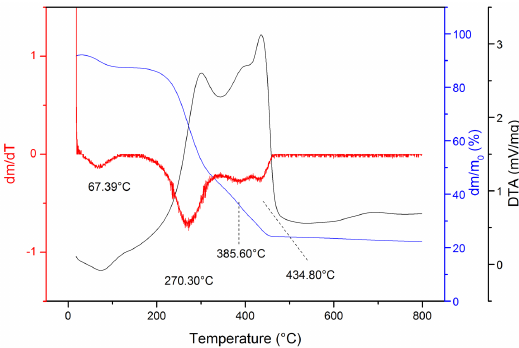
Figure 6. TG/DTG/DTA curves of UV15 BF. Bibliographic source: